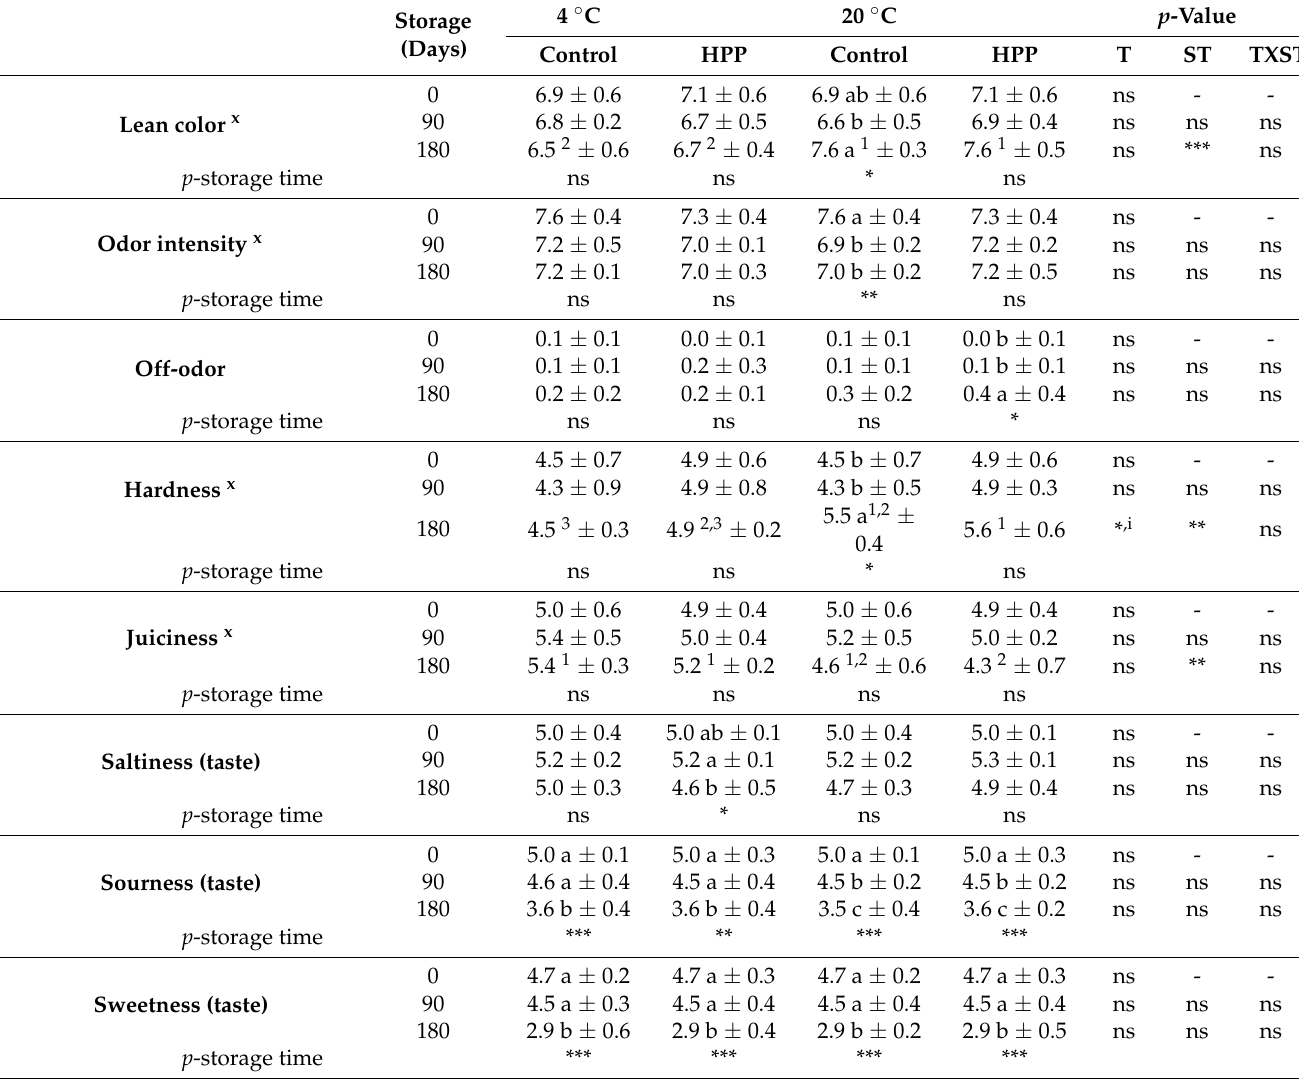
Table 4. Sensory characteristics (means ± standard deviation) of sliced Iberian chorizo HPP-treated (HPP) or not (Control), not stored (0) or stored at 4 or 20 ◦ C for 90 or 180 days, and significance from a one-way (storage time) ANOVA, a one-way (T, HPP) ANOVA on day 0 data, and from a two-way (T, HPP; ST, storage temperature) ANOVA with interaction. For variables with significant interaction in Table 5, a Simple Main Effects test was